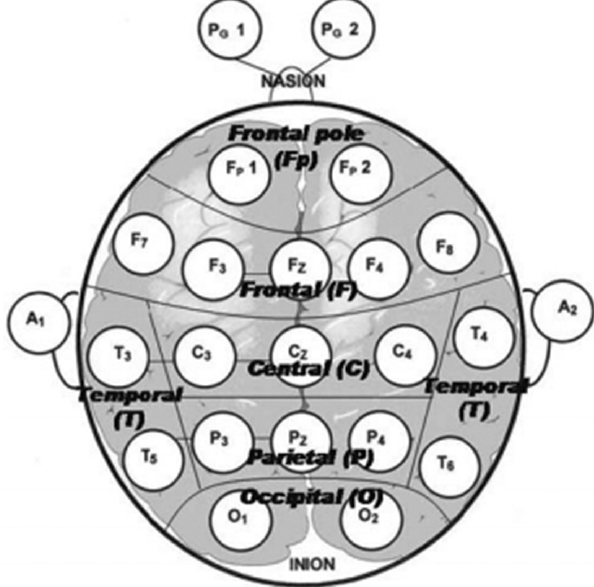
Fig. 1. Scalp placement and labels for Electrodes used in the International 10–20 system